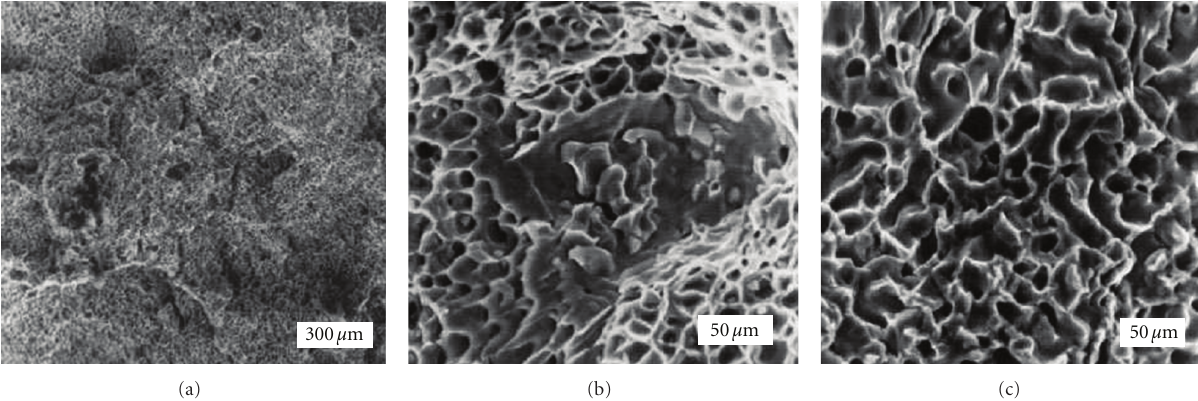
Figure 6: Fractography of the iron grade OSCh 6-2 with 7.3% porosity (a, b) and with 20% porosity (c) specimens: (a) × 100; (b) × 750; (c) ×